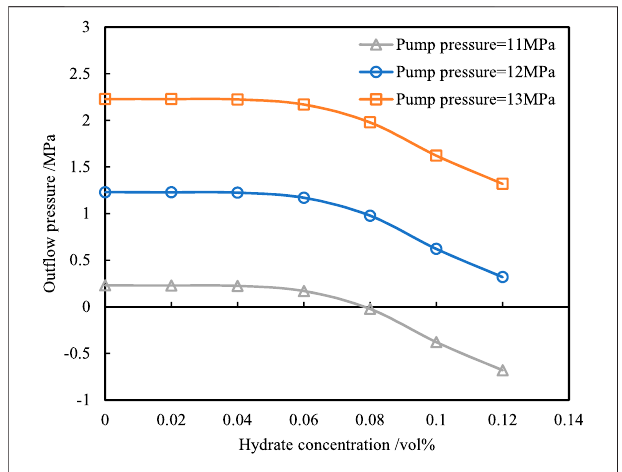
FIGURE 6 | The out fl ow pressures at the platform along hydrate concentrations under varied pump pressure